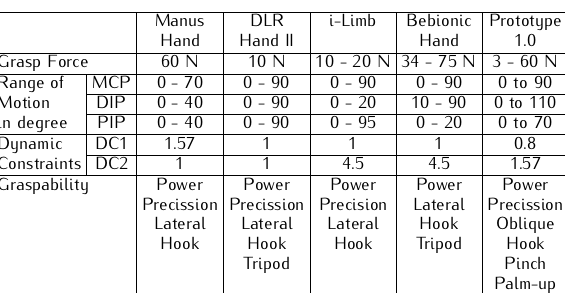
Table 4. Kinematic Characteristics Comparison of Prototype 1.0 with four Pros- theses (Charateristics are adapted from Table III and IV in [4])